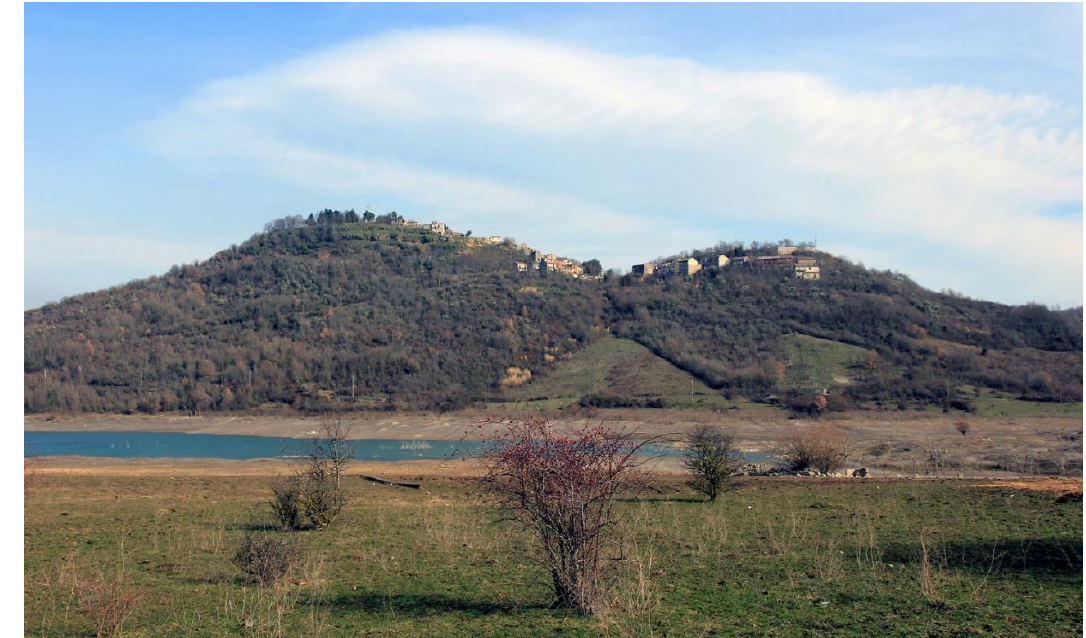
Figure 11. Conza della Campania: overview of the old village destroyed by the 1980 earthquake (photos by [35,36]).